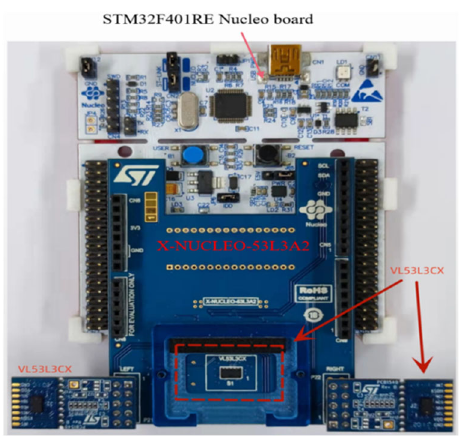
Figure 2. Driving module. Figure 2. Driving